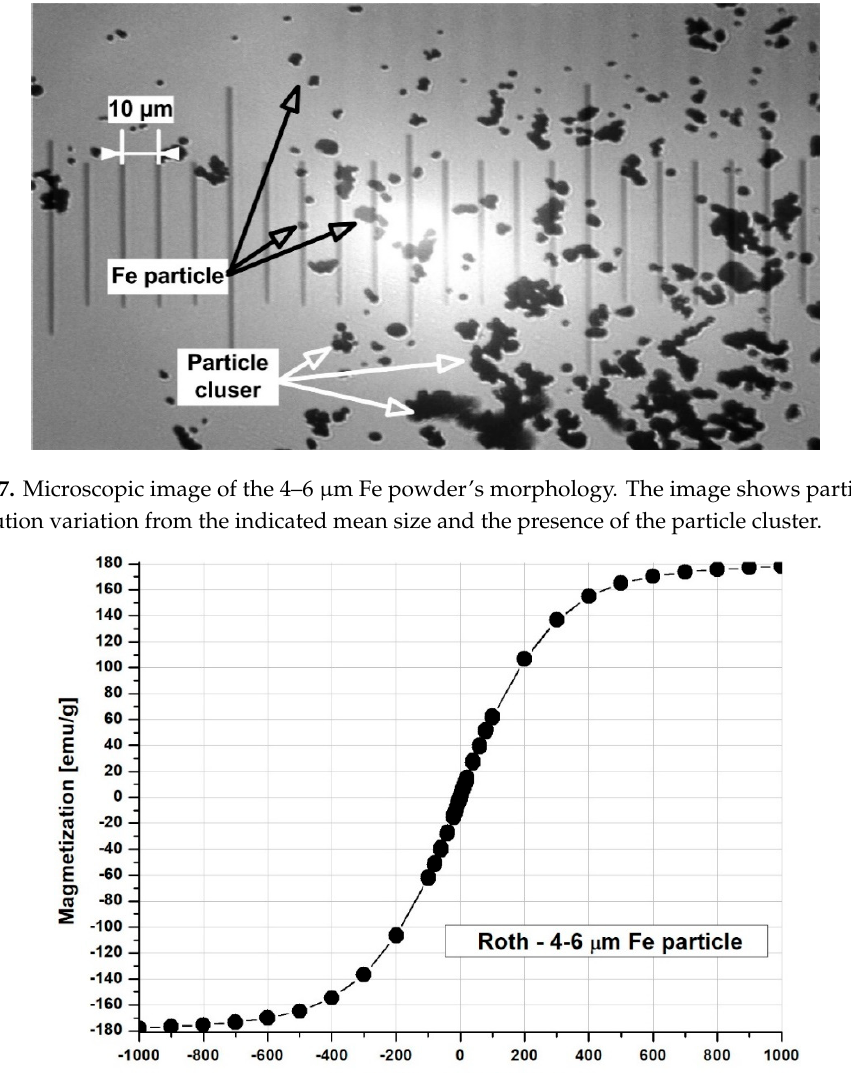
Table 4. Fe particle magnetic properties (particles size of 4–6 μ m). Saturation Magnetization